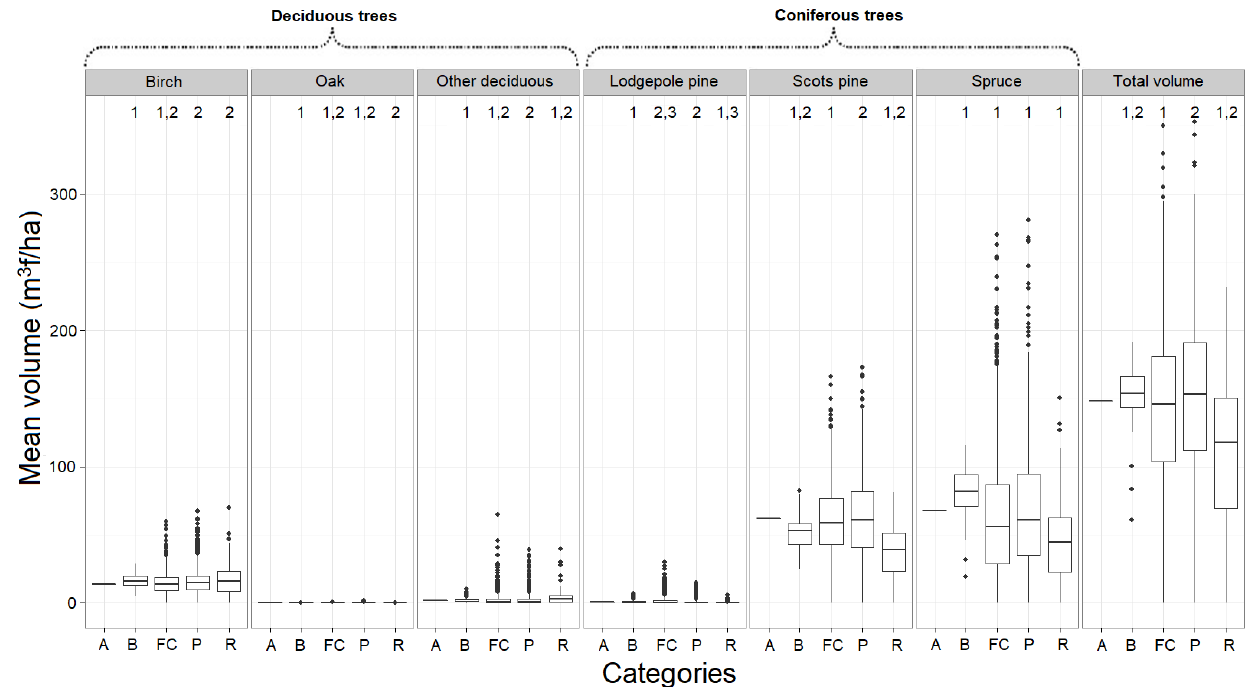
Figure 5. Boxplots of the mean volume in m3f/ha (cubic meter standing volume per hectare) in 2010, per A: entire study region, B: buffer zones around restored sites, FC: forest company owned land, P: protected areas, R: restored sites. Equal numbers displayed above bars denote significance between categories ( p ≤ 0.050).